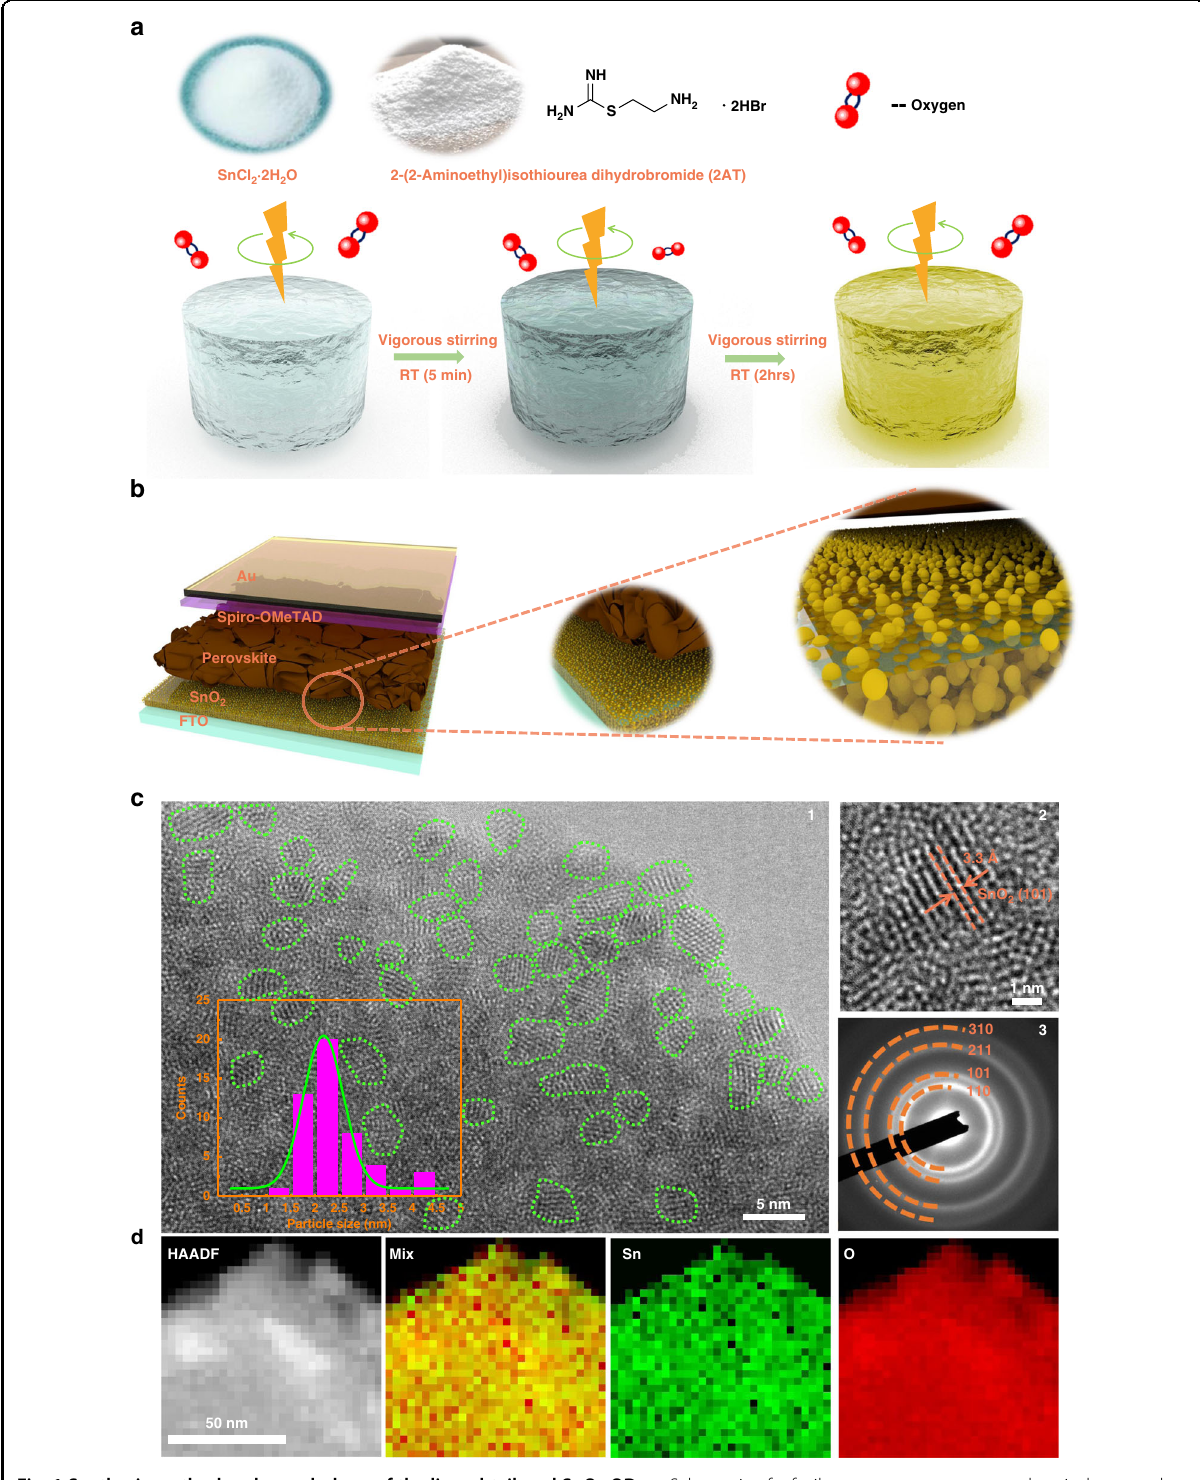
Fig. 1 Synthesis method and morphology of the ligand-tailored SnO 2 QDs. a Schematic of a facile one-step aqueous wet-chemical approach to rapid formulate multi-functional SnO 2 QDs. b Schematic of a planar perovskite solar cell device structure using an electron transporting layer of SnO 2 QDs. c 1. TEM image of SnO 2 QDs coated on a carbon support copper grid. Inset shows the particle size distribution of SnO 2 QDs. Note that the irregular green circle is the guideline of the SnO 2 QDs edge. 2. High-resolution TEM of SnO 2 QDs. The lattice fringes of the (110) crystal plane with a space distance of around 0.33 nm are clearly observed. 3. Selected area electron diffraction (SAED) pattern of SnO 2 QDs. Electron re fl ection rings from the (110), (101), (211), and (310) crystal planes of SnO 2 were clearly observed. d Selected area of high-angle annular dark- fi eld (HAADF) STEM image of SnO 2 QDs and the corresponding STEM-EELS maps of Sn and O